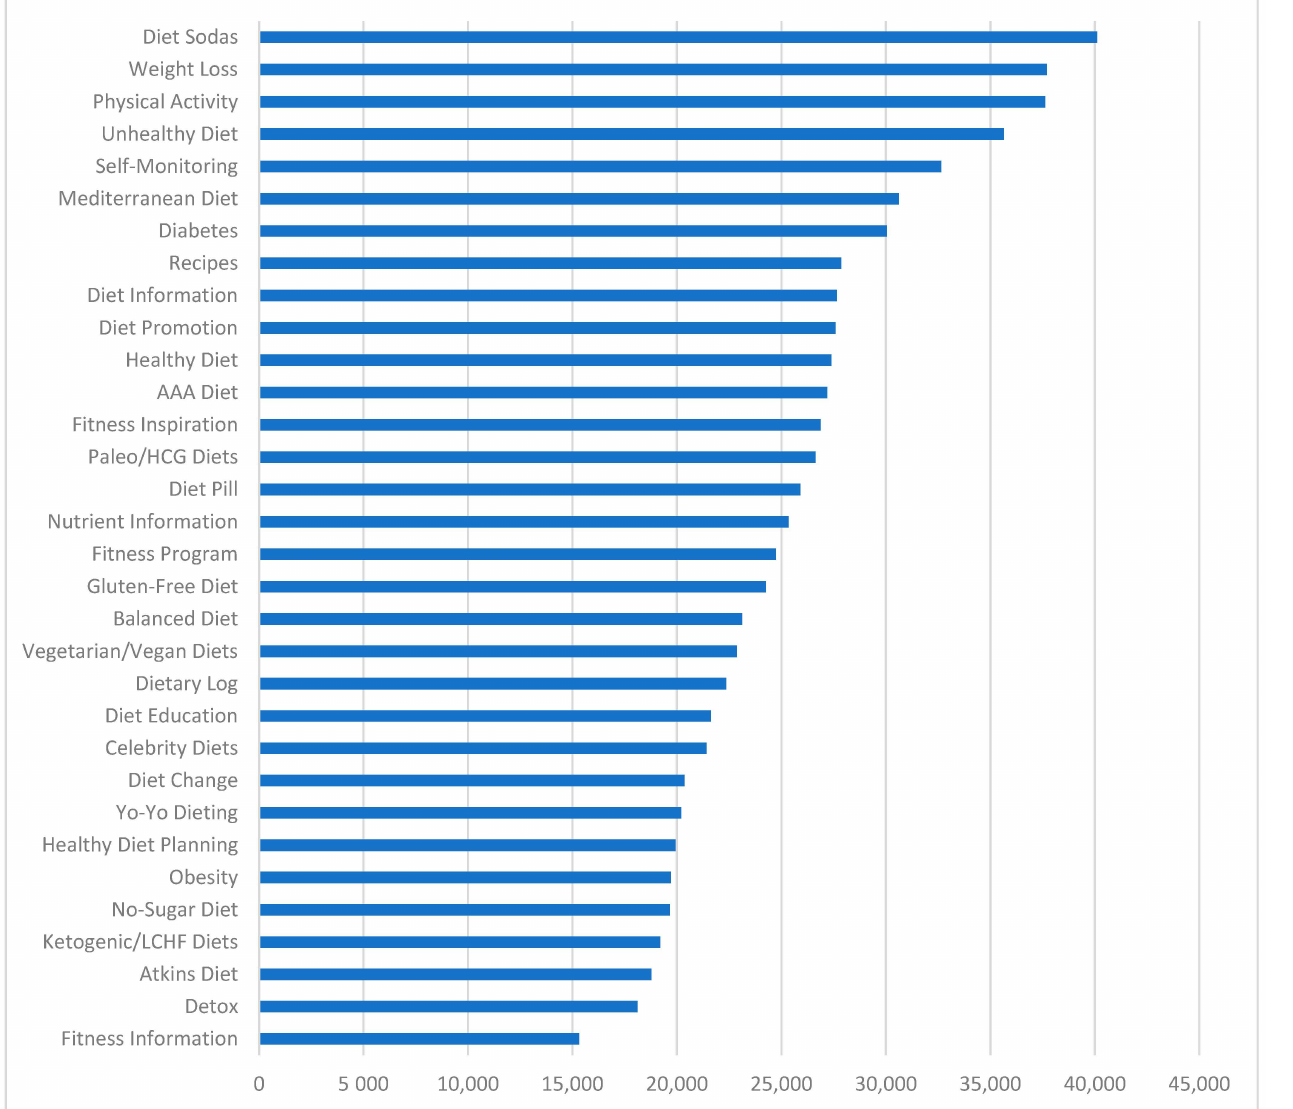
Figure 4. The number of predominant tweets in each topic.